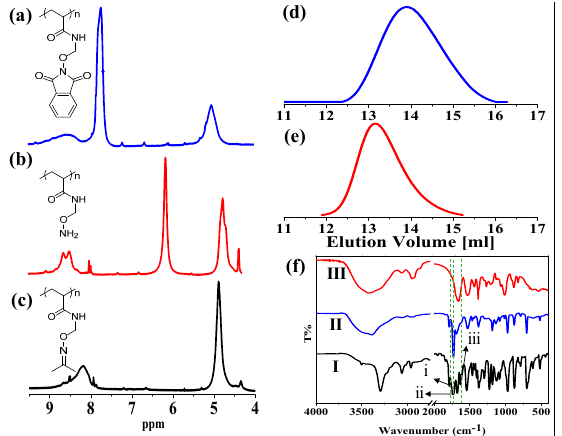
Figure 1. 1 H NMR spectra of ( a ) PNAMAm- p ; ( b ) PNAMAm, and; ( c ) PNAMAm-m; GPC spectra of;